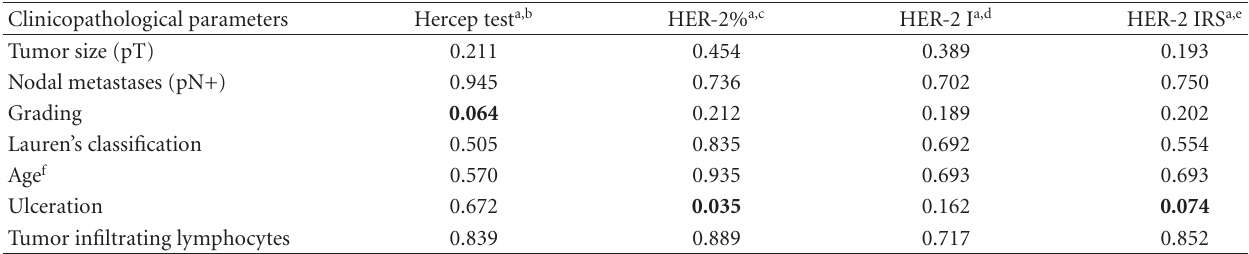
Figure 1: Immunohistochemical expression of HER-2 in gastric cancer tissue: (a) Hercept test: 1+, IRS: 4, × 200; (b) Hercep test: 2+, IRS: 8, × 200; (c) HercepTest: 3+, IRS: 12, × 200; (d) Hercep test: 3+, IRS: 12, × 200. Table 3: Correlations between HER-2 expression and clinicopathological